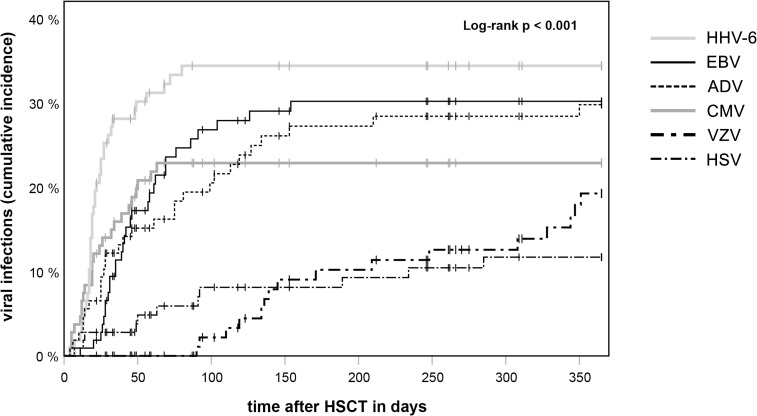
Cumulative incidence of viral infections after HSCT.Time until the first positive testing of infections with Epstein-Barr virus (EBV), cytomegalovirus (CMV), human herpesvirus 6 (HHV-6), adenovirus (ADV), herpes simplex virus (HSV) and varicella zoster virus (VZV) are presented in a Kaplan-Meier graph. Time until first positive testing differed significantly between the tested viruses with a p-value of < 0.001 in the Log-rank test.